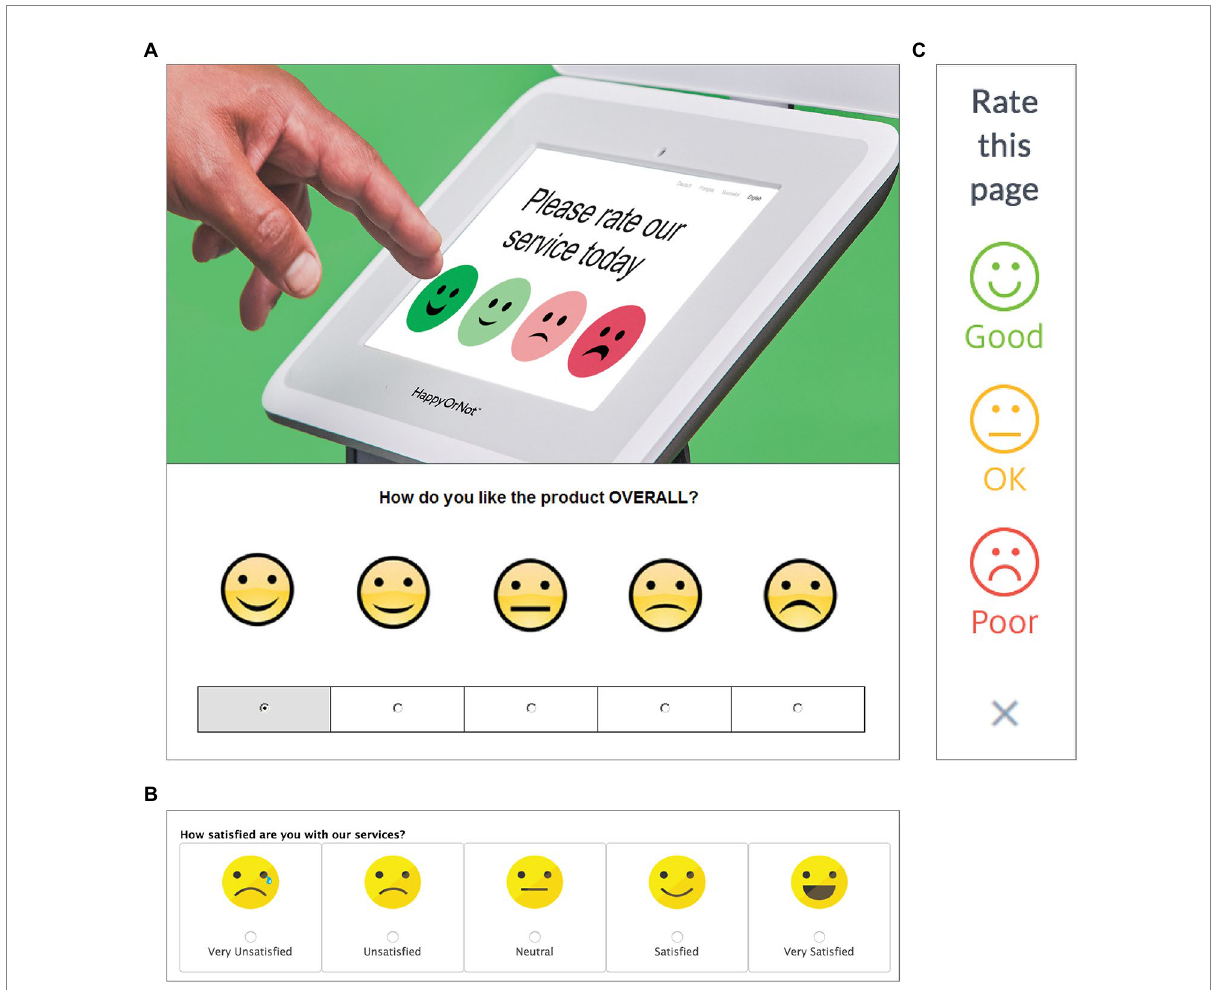
FIGURE 3 The left–right spatialization of emotions on rating scales often violates the GOOD IS RIGHT mapping characteristic of most people (i.e., right- handers). (A) Interfaces that are congruent with that mapping (B) , are necessarily incongruent with the GOOD IS LEFT mapping of left-handers. Vertical rating scales (C) leverage the universal GOOD IS UP mapping shared by all users. Reproduced with permission from Happy or Not, available at